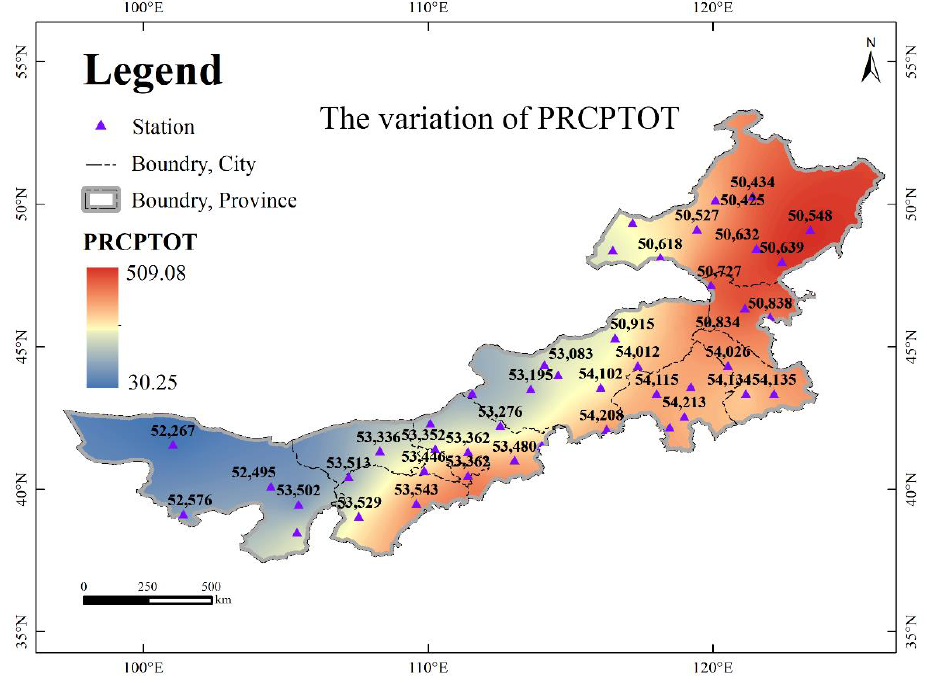
Figure 4. Spatial distribution of the mean PRCPTOT.